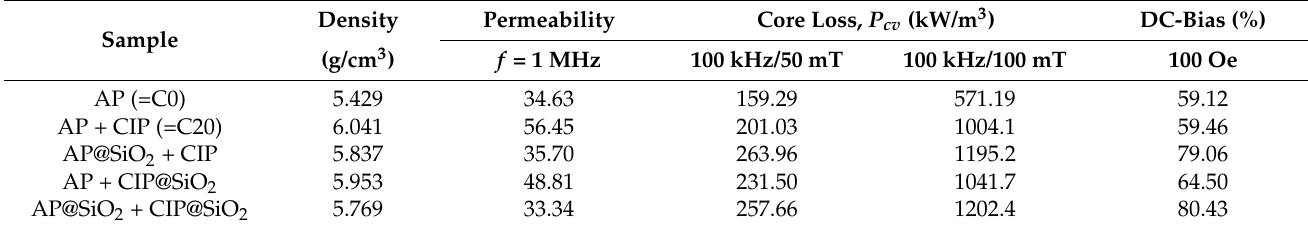
Table 3. Comparison of density and electromagnetic properties between hybrid SMCs.